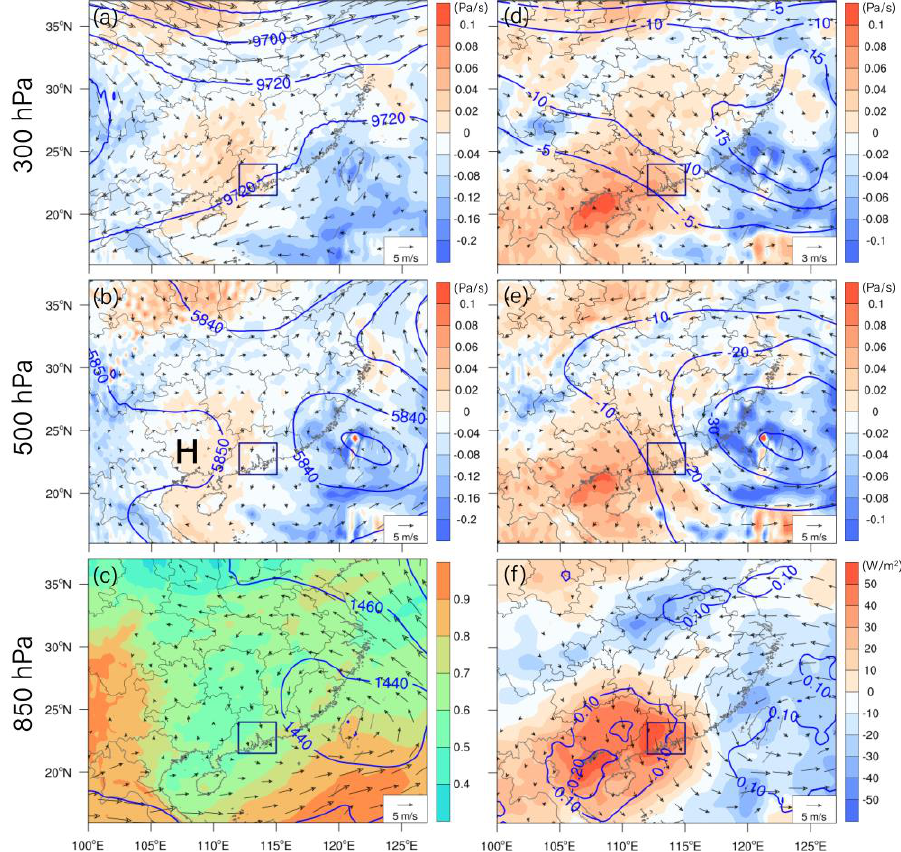
Figure 6. Synoptic backgrounds for the PRD-only heatwaves. ( a ) The 300 hPa geopotential height (blue contours; unit: gpm), horizontal wind vector (arrows), and vertical velocity (shadings). ( b ) Same as ( a ), but at 500 hPa. ( c ) Geopotential height (blue contours; unit: gpm) and horizontal wind vector (arrows) at 850 hPa, and total cloud cover (shadings). ( d ) Anomalies of geopotential height (blue contours; unit: gpm), horizontal wind vector (arrows), and vertical velocity (shadings) at 300 hPa. ( e ) Same as ( d ) but at 500 hPa. ( f ) Anomalies of total cloud cover (blue contours), 850 hPa horizontal wind vectors (arrows), and net solar radiation at the surface (shadings; positive downward). Navy rectangle denotes the PRD region. Gray lines indicate the national and provincial boundaries and coastal lines.